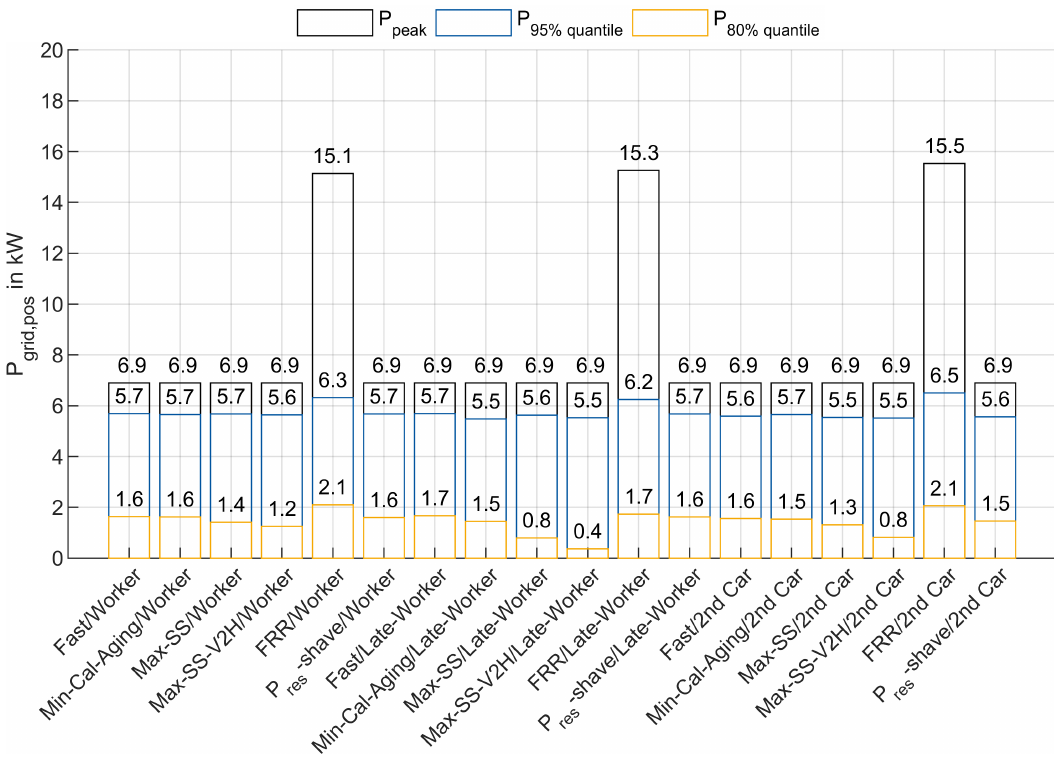
Figure A8. Positive power exchange of the household with the grid for home and workplace charging scenario H + W without SoC V 2 XLimit